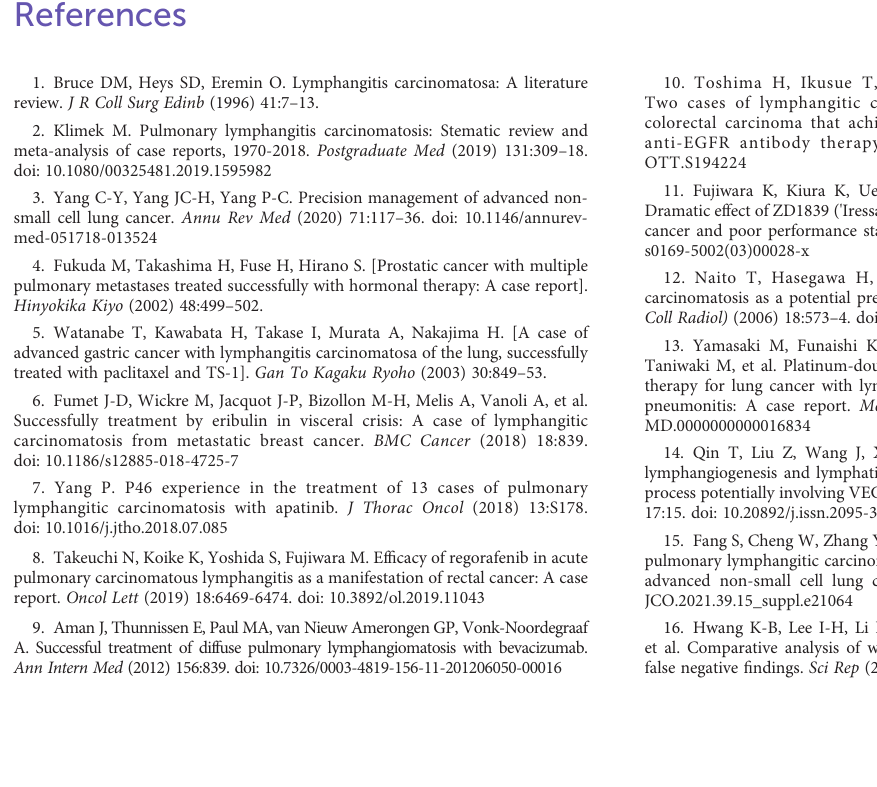
SUPPLEMENTARY FIGURE 1 Genomic pro fi ling of Chinese-LUAD cohort (778 patients). Alterations presented here included single nucleotide variation/insertion and deletion/copy number variation, etc.. Genes were listed according to the 30 top altered genes in PLC-LUAD cohort. SUPPLEMENTARY FIGURE 2 Kaplan-Meier survival analysis in patients with adenocarcinoma and squamous treated by anlotinib. (A) Plots of progression-free survival (PFS); (B) Plots of overall survival (OS). SUPPLEMENTARY FIGURE 3 Kaplan-Meier survival analysis and comparison of survival between group of anlotinibandotherinpatientswithadenocarcinoma(log-ranktest, P<0.05 ). (A) Plots of progression-free survival (PFS); (B) Plots of overall survival